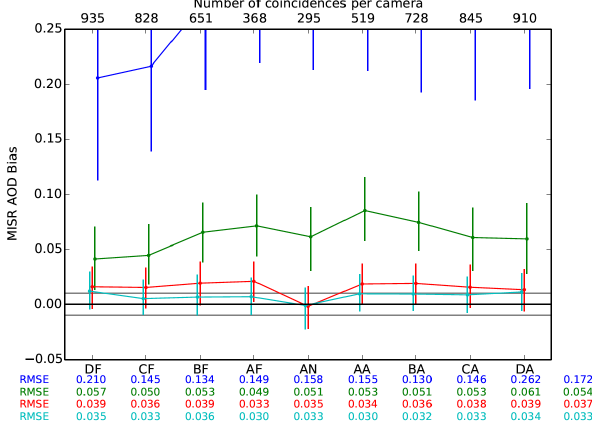
Figure 3. RA baseline case bias plots. The plot shows the aggre- gated AOD bias in each MISR channel (calculated according to the rightmost branch of Fig. 1), when all the validation data used in the study are included. The points represent the median values for each particular wavelength and camera; the vertical bars represent the 25th–75th percentiles. The count is shown for each camera near the top of the plot, and the RMSE (for each camera and spectral band) is shown near the bottom, color-coded by spectral band. The numbers on the bottom right give the camera-averaged values for the RMSE. Median values in the blue band are off-scale for nearly all cameras. The grey horizontal lines are centered on ± 0.01, for reference. The overall statistics for each spectral band (following the left branch of Fig. 1) are given as the “RA Baseline” entries in Table